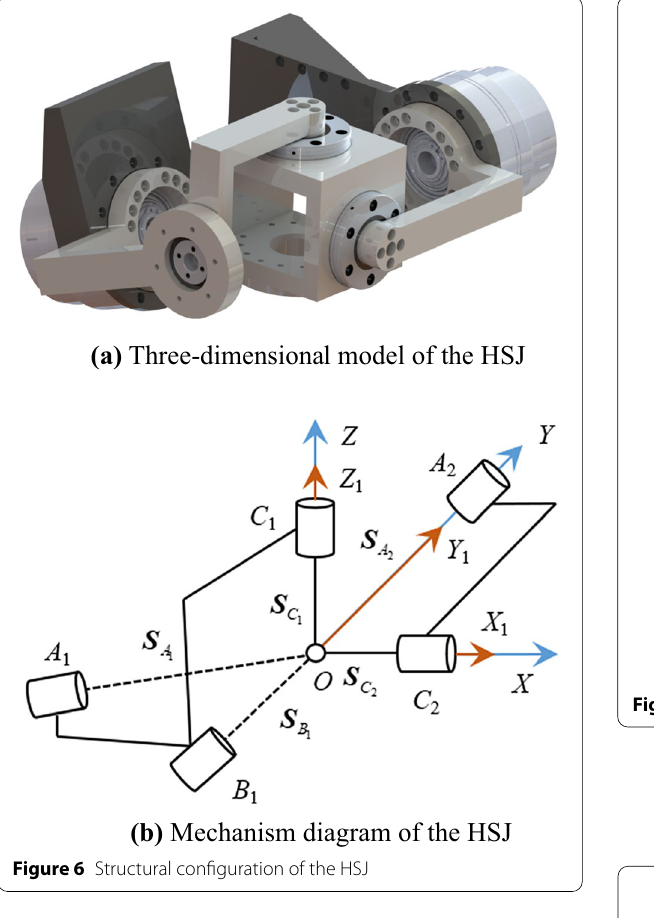
(a) Three-dimensional model of the HEJ